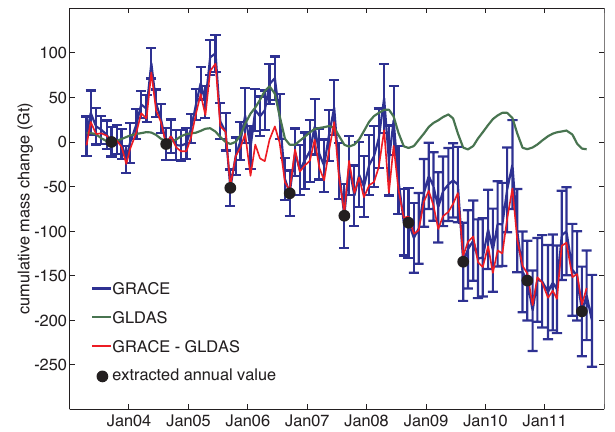
Fig. 2. Baffin and Bylot Island monthly cumulative mass change from GRACE shown in blue (with 95% confidence intervals), from GLDAS shown in green, and for GRACE corrected with GLDAS shown in red. Black dots show summer minima selected as annual